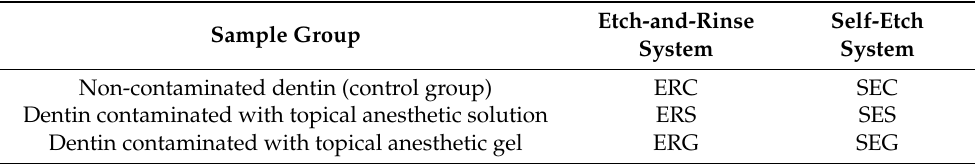
Table 1. Sample groups ( n = 15 specimens for each group).